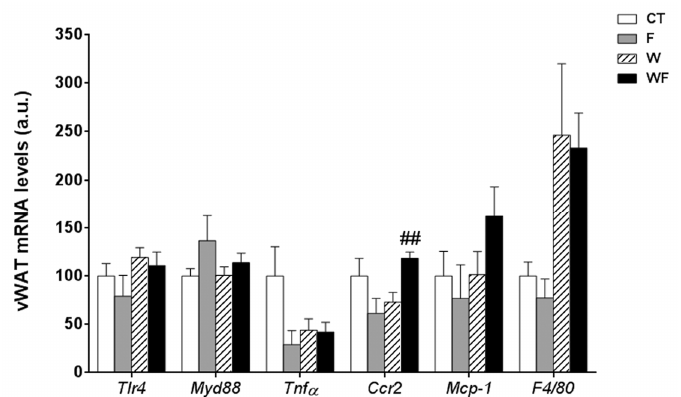
Figure 1. Bar plots showing the relative levels of specific mRNAs of pro ‐ inflammatory molecules from Control (CT, mice fed standard solid-chow), Fructose (F, mice fed standard solid-chow plus a 15% fructose solution ad libitum), Western (W, mice fed Western solid-chow), and Western + Fructose (WF, mice fed Western solid-chow plus a 15% fructose solution ad libitum), represented as mean (a.u., arbitrary units) ± SEM of five different visceral adipose tissue samples. ## p < 0.01 vs. W values.